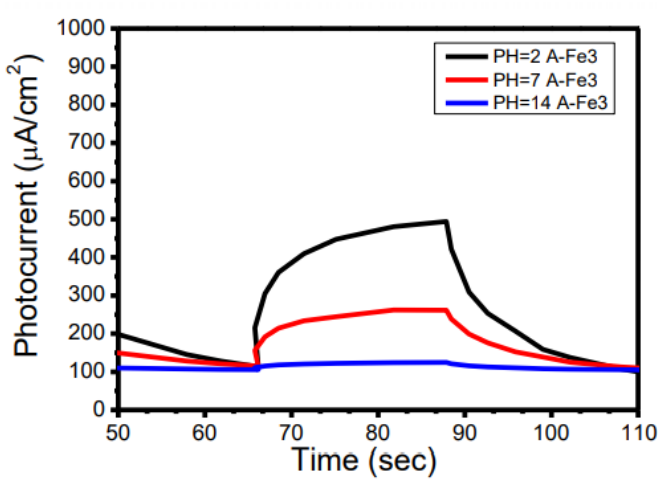
Figure 7. Chronoamperograms (at 0.80 V (vs. Ag/AgCl), with light illumination (100 W halogen lamp) of flexible FTO slides coated with thin films comprising of A-Fe3 at different pH values.